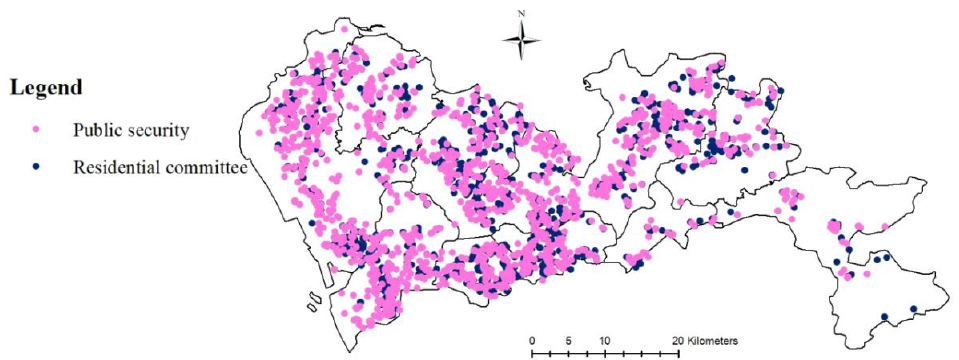
Figure 3. Distribution of POI for government departments under the lockdown of COVID-19.